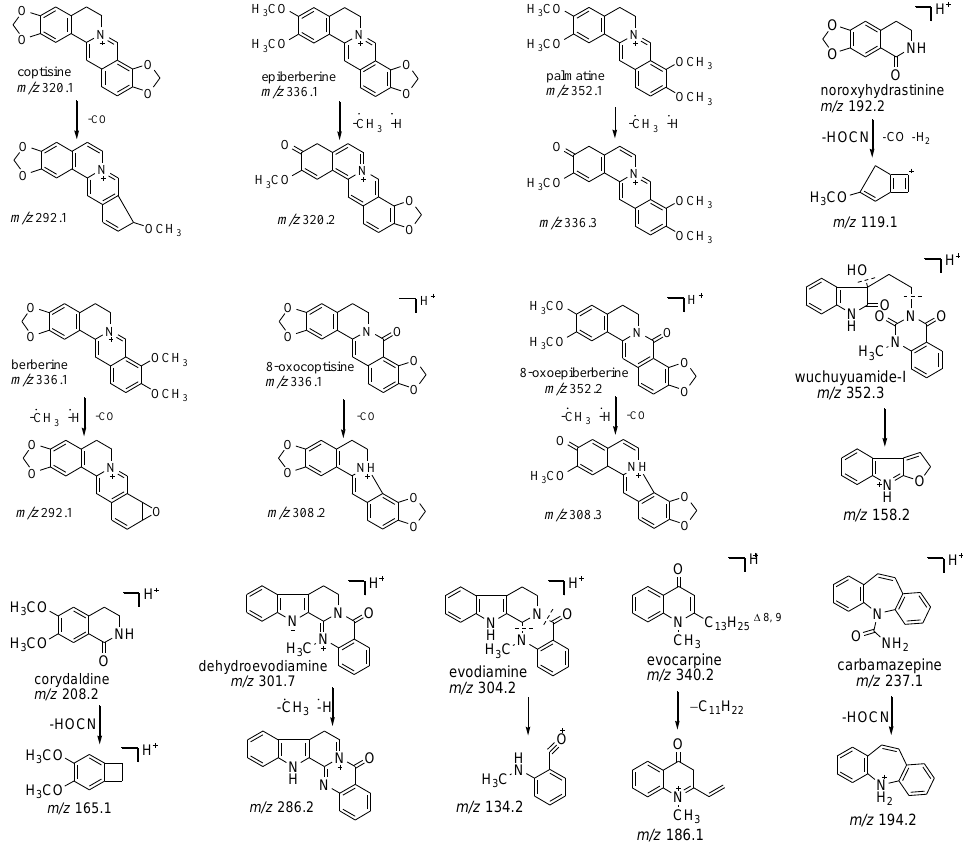
Figure 1. Chemical structures of the precursor and product ions of the 12 alkaloids and carbamazepine (internal standard, IS).